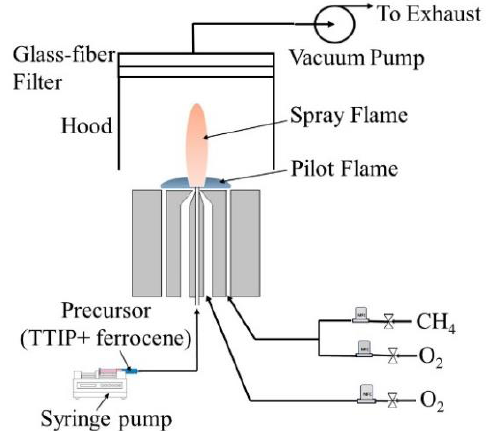
Figure 17. Schematic of flame spray pyrolysis (FSP) apparatus.